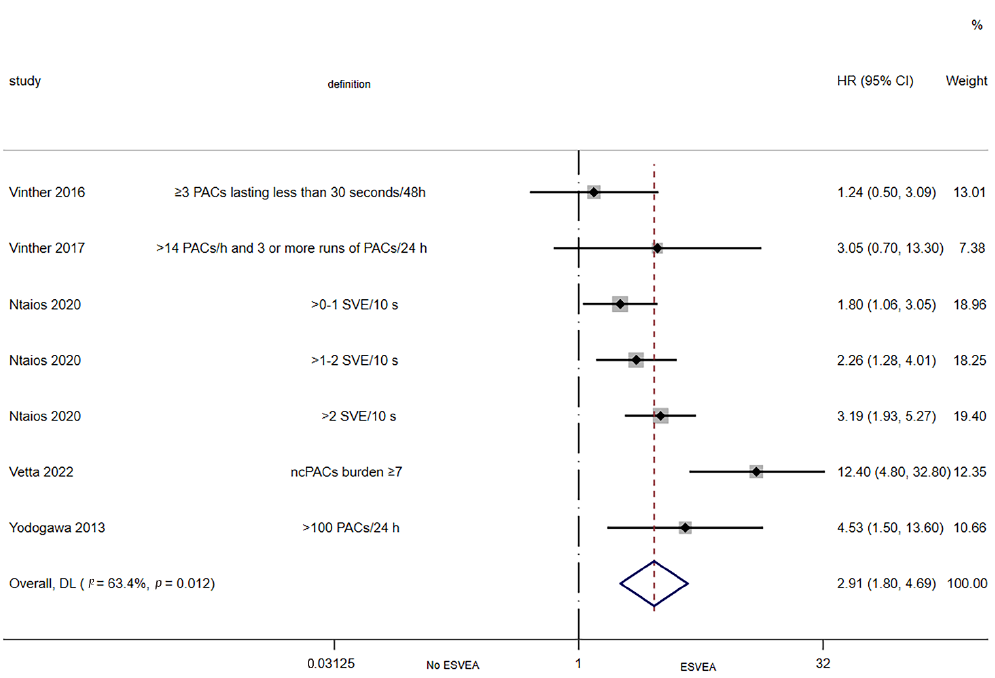
Figure 3. Forest plot of the association between ESVEA and AF in the ischemic stroke patients. Abbreviations: PACs—premature atrial complexes; SVE—supraventricular extrasystoles; ncPACs— non-conducted premature atrial complexes; ESVEA—excessive supraventricular ectopic activity; HR—hazard ratio; CI—confidence interval. Definition represents the definitions of ESVEA in different studies [22,33,36,39,41].